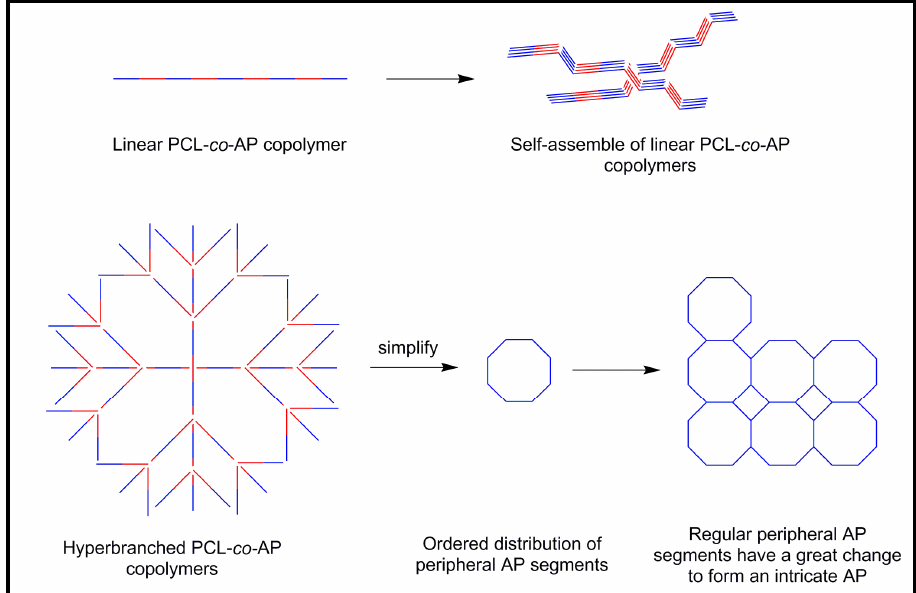
Figure 15. Model explaining the higher conductivity of hyperbranched copolymers than the linear ones with the same content of conductive